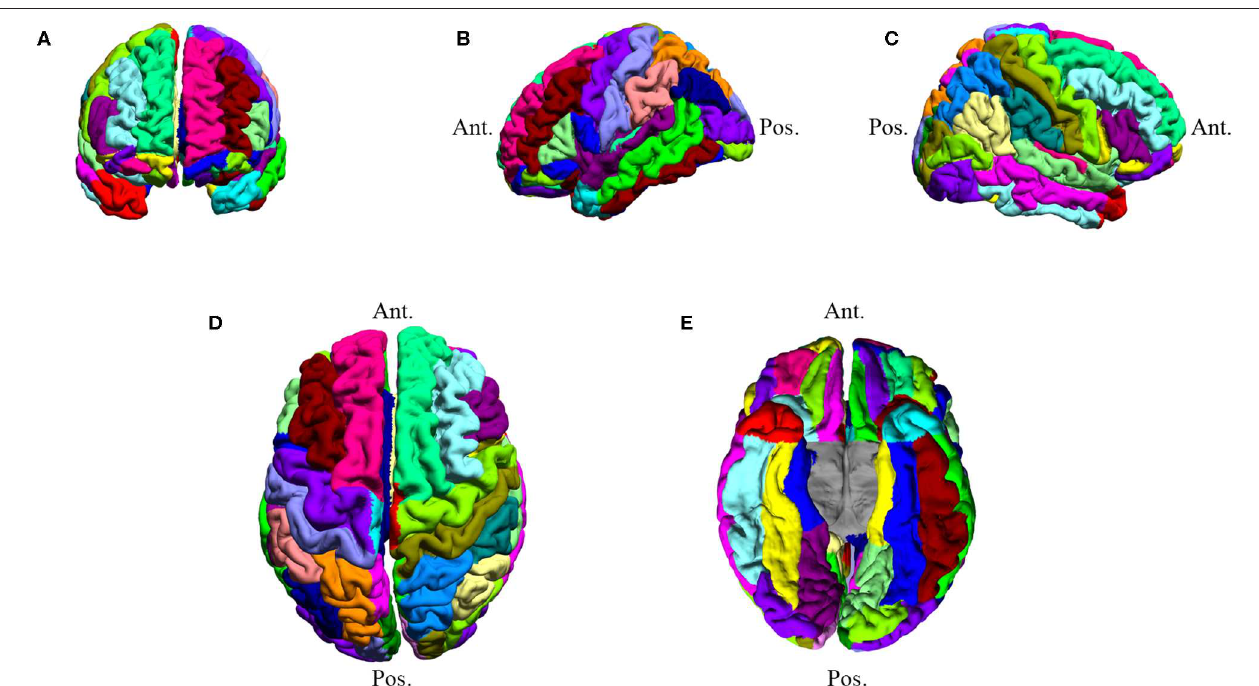
FIGURE 1 | Subject DT007: BrainSuite processed MR image. The image underwent brain segmentation to determine COI values. DT007 was a 57-year-old male with a high-grade glioblastoma and presented with seizures. Colors are used to distinguish ROIs. (A) Anterior coronal view (B) Left hemisphere view (C) Right hemisphere view (D) Superior axial view (E) Inferior axial